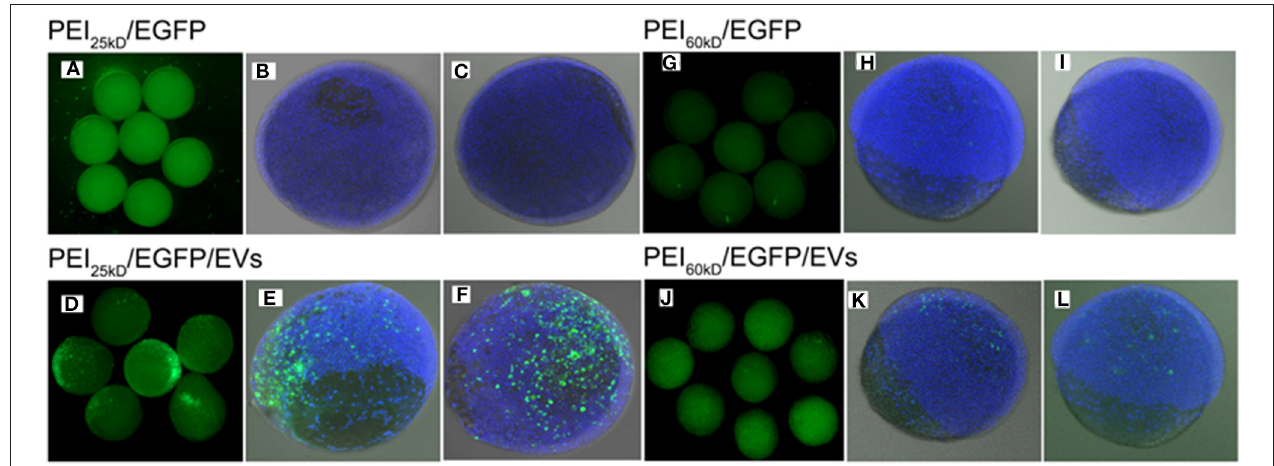
FIGURE 7 | Fluorescence images of (A–C) PEI 25kD /EGFP, (D–F) PEI 25kD /EGFP/EVs, (G–I) PEI 60kD /EGFP, and (J–L) PEI 60kD /EGFP/EVs in zebrafish embryos 8h after injection.